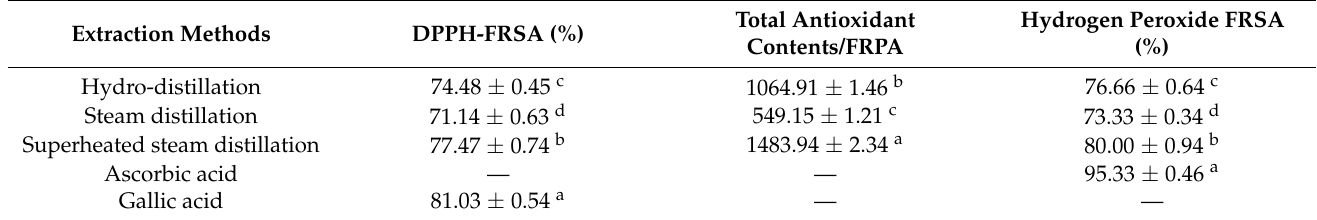
Table 3. DPPH free radical scavenging, hydrogen peroxide scavenging, and total antioxidant/FRAP activities of clove essential oils extracted by different extraction